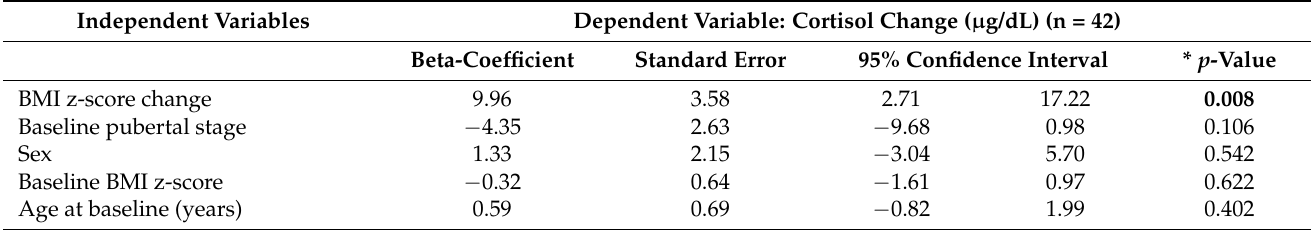
Table 7. Multivariate regression analysis results between BMI z-score change and cortisol change.